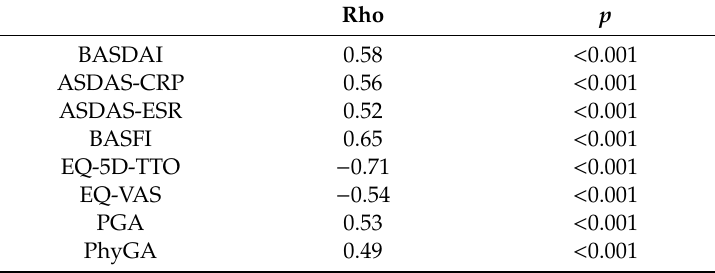
Table 3. Spearman correlation between ASAS HI scores and other patient-reported outcomes (PROs). Rho p BASDAI 0.58 < 0.001 ASDAS-CRP 0.56 < 0.001 ASDAS-ESR 0.52 < 0.001 BASFI 0.65 < 0.001 EQ-5D-TTO − 0.71 < 0.001 EQ-VAS − 0.54 < 0.001 PGA 0.53 < 0.001 PhyGA 0.49 <